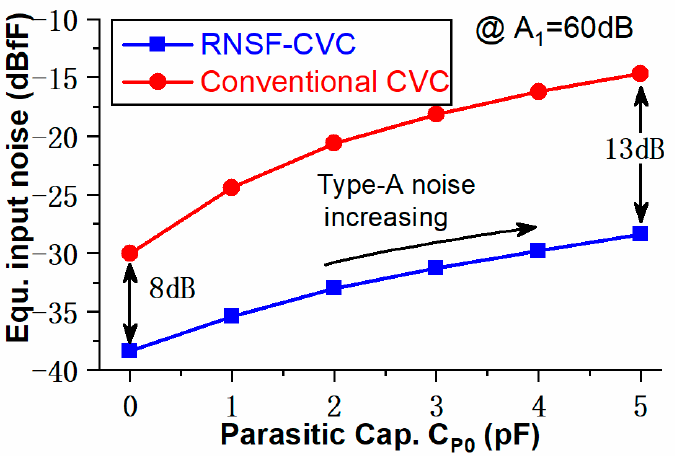
Figure 13. The noise reduction effectiveness of the RNSF technique varies with parasitic capacitance.